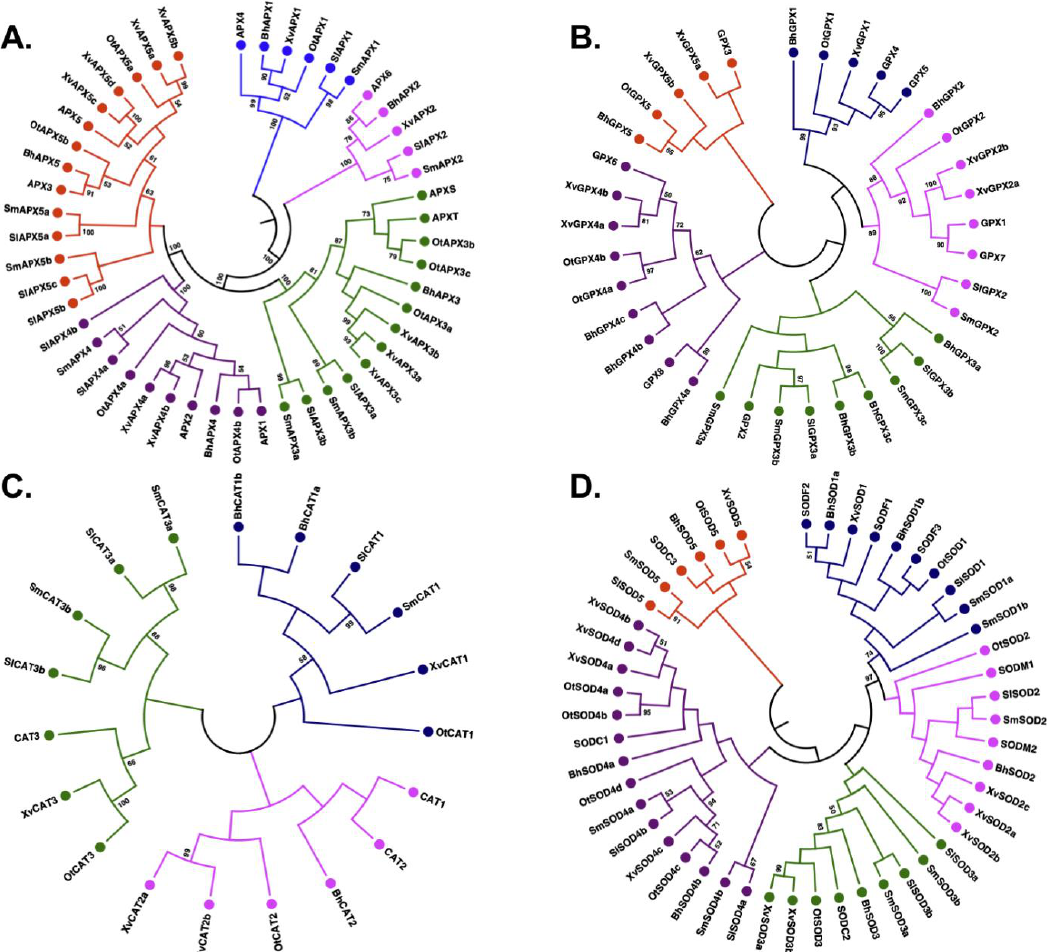
Figure 2. Phylogenetic analysis of APX, GPX, CAT and SOD proteins. The phylogenetic tree for each gene family was constructed by the Neighbor-joining method implemented in MEGA7 with 500 bootstraps using orthologs from Arabidopsis thaliana . ( A ) APX proteins were divided into five clades, ( B ) GPX proteins were divided into five clades, ( C ) CAT proteins were divide into three clades, and ( D ) SOD proteins were divided into five clades. Different clades of trees are shown in different colors: I, blue; II, pink; III, green; IV, purple, and V, red. Bootstrap values of ≥ 50 are indicated. Similar to the APX family, the phylogenetic analysis classified the identified GPX members into five major clades (Figure 2B). Clade I consisted of three members with extracellular localization, one each from B. hygrometrica , O. thomaeum and X. viscosa , while no GPX gene from S. moellendorffii and S. lepidophylla was included (Table S2). Clade II consisted of six members with mitochondrial/chloroplastic localization. It was formed by one member each from the five species except X. viscosa , which had two GPX genes in this clade. The other three clades were characterized by cytoplasmic-localized GPXs (Table S2). Clade III enclosed eight members, including three from B. hygrometrica , three from S. moellendorffii , and two from S. lepidophylla . Clade IV was marked by seven proteins containing three members from B. hygrometrica and two each from X. viscosa and O. thomaeum . Two genes of X. viscosa and one gene each from B. hygrometrica and O. thomaeum were clustered in Clade V, together with GPX3 of Arabidopsis .